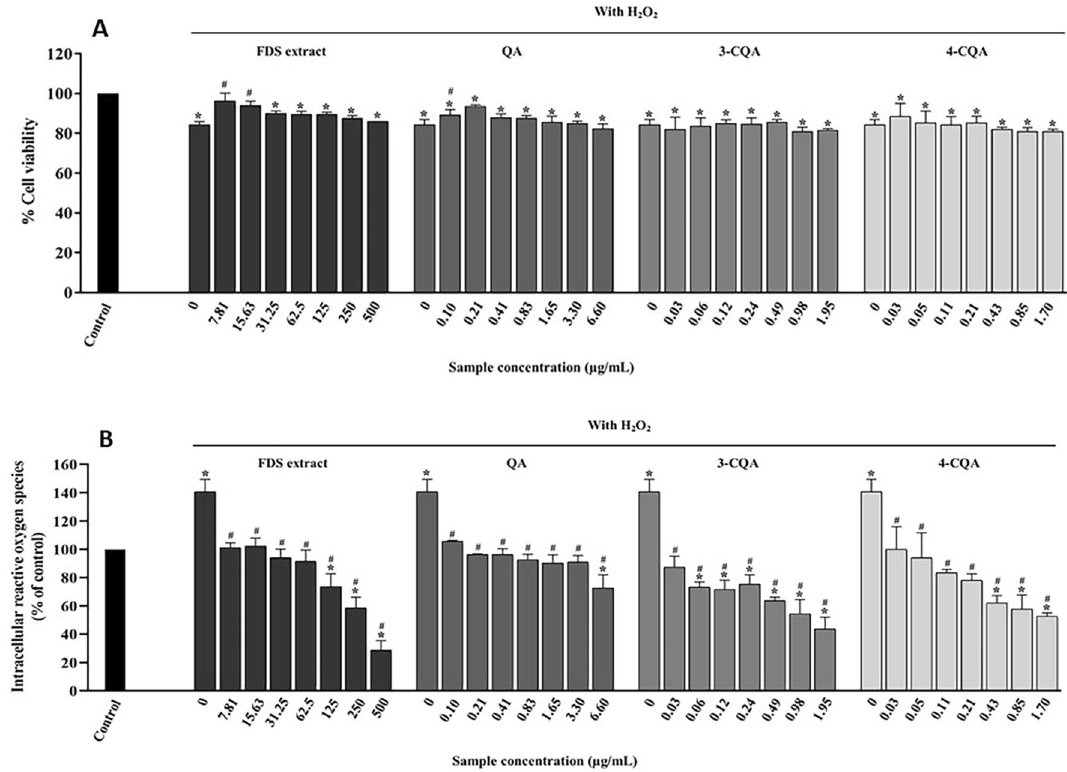
Figure 6. ( A ) HaCaT cell viability was determined via MTS assay. The cells were treated with various concentrations of the F. dubia sap (FDS) extract, quinic acid (QA), 3- O -caffeoylquinic acid (3-CQA), or 4- O -caffeoylquinic acid (4-CQA) for 24 h before exposure to H 2 O 2 (100 µM) for 30 min. ( B ) Inhibition of H 2 O 2 - induced ROS generation by the extracts and compounds in HaCaT cells. The cells were pretreated with the FDS extract, QA, 3-CQA, or 4-CQA for 24 h and then treated with H 2 O 2 for 30 min. The levels of intracellular reactive oxygen species were monitored after an inner salt 2 ′ ,7 ′ dihydrofluorescein diacetate fluorescent dye was introduced into the cells. The symbols * and # represent significantly different data at p -values ≤ 0.05 compared to non-H